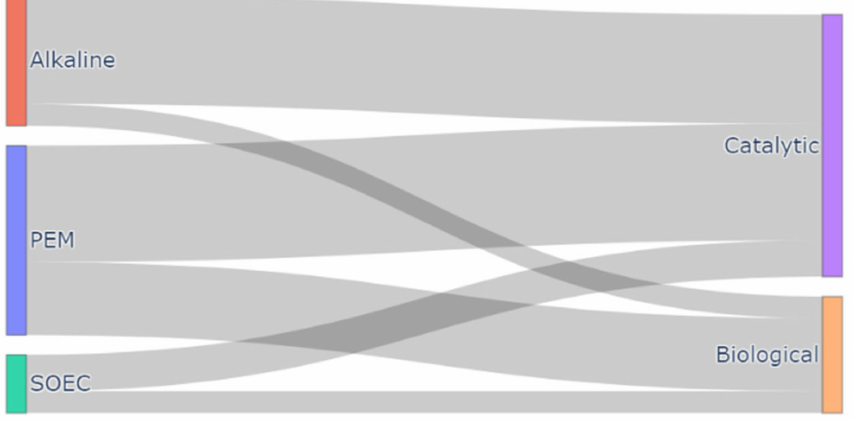
Figure 7. Sankey diagram showing coupling between electrolysis and methanation technologies.